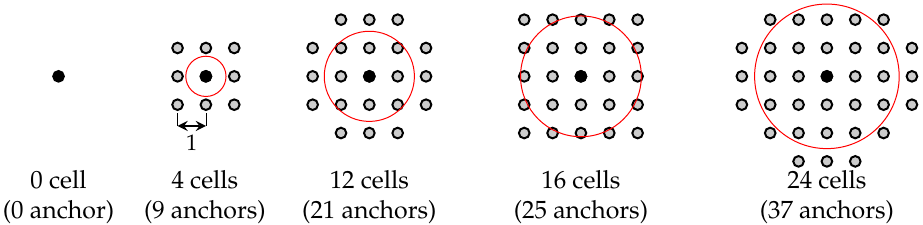
Figure 18. Illustration of the grid topology generation process. In this example, the following radii are used: 0, 0.71, 1.59, 2.13 and